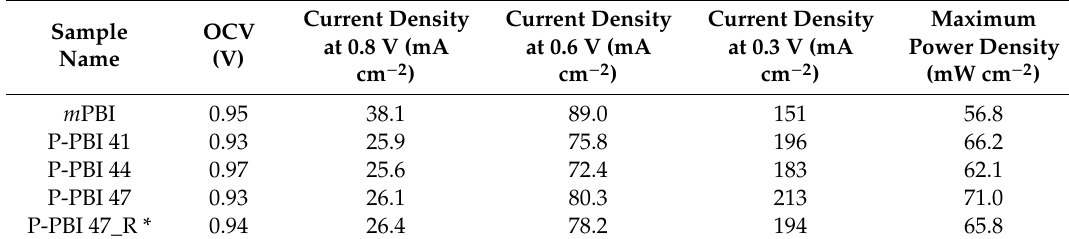
Table 4. Summary of the performance results from I-V curves of membrane-electrode assemblies using m PBI and P-PBI membranes.